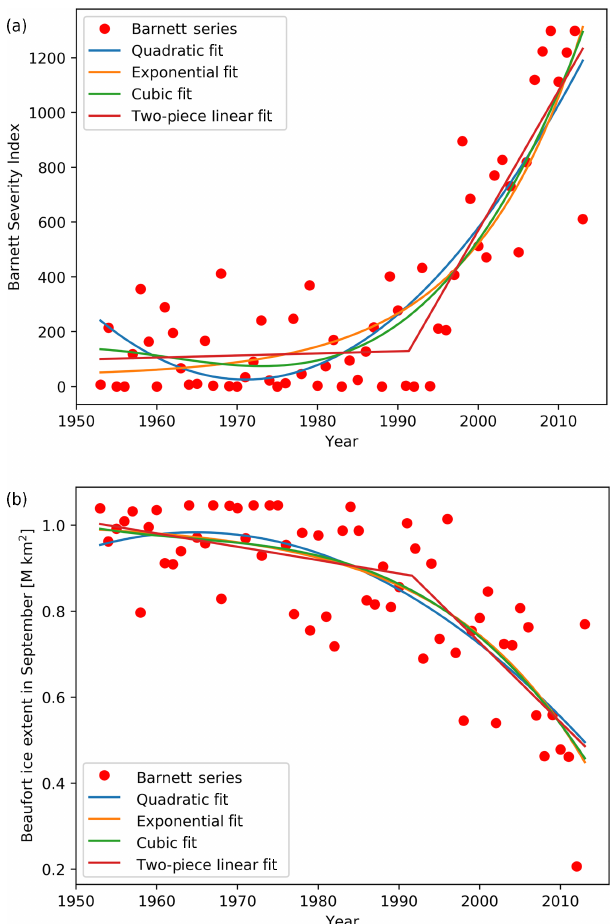
Figure 4. Examples of different fit methods (see legend) applied to the BSI (a) and the September Beaufort ice extent time series (b)